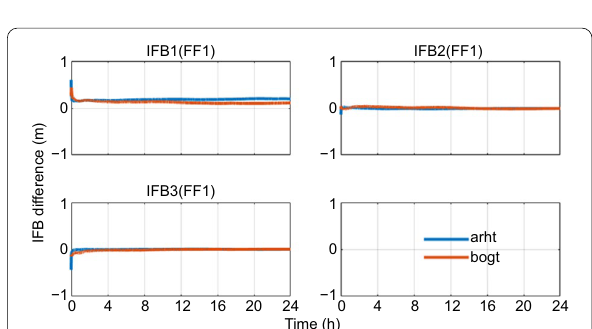
Fig. 13 Difference of receiver IFB estimates with respect to MGEX reference IFBs at stations arht and bogt (DOY 283, 2021)